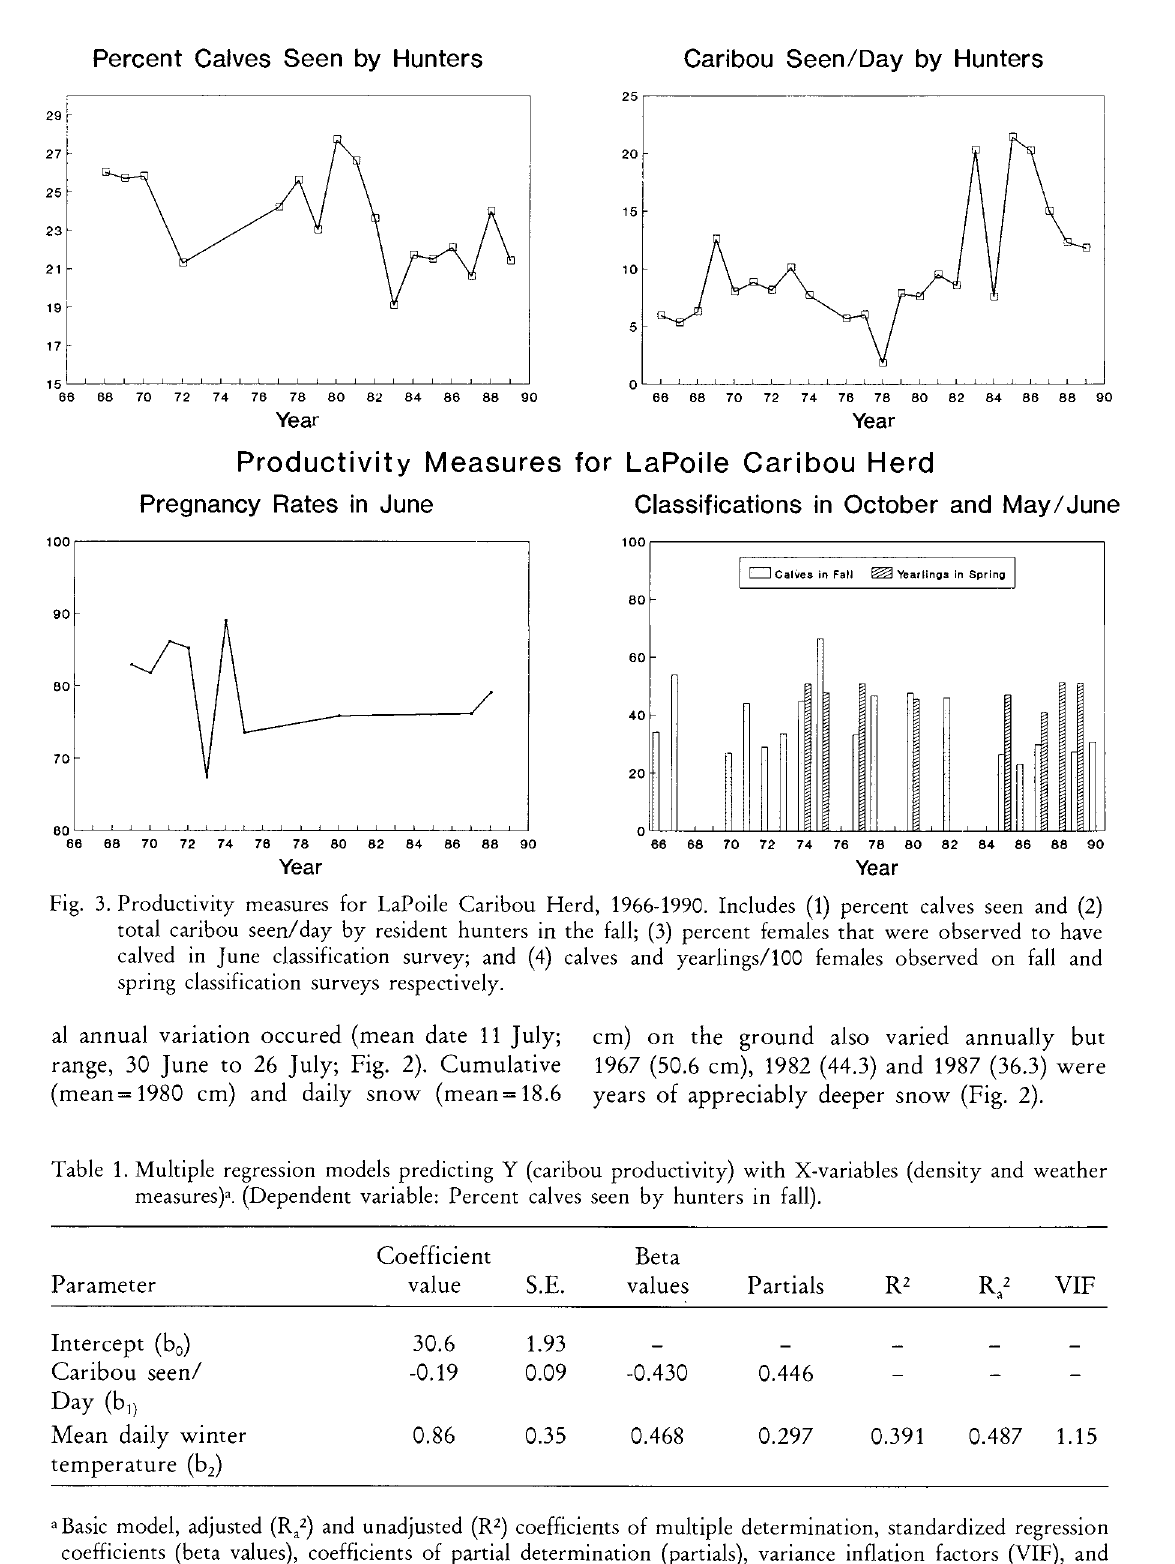
Table 1. Multiple regression models predicting Y (caribou productivity) with X-variables (density and weather measures) 3 . (Dependent variable: Percent calves seen by hunters in